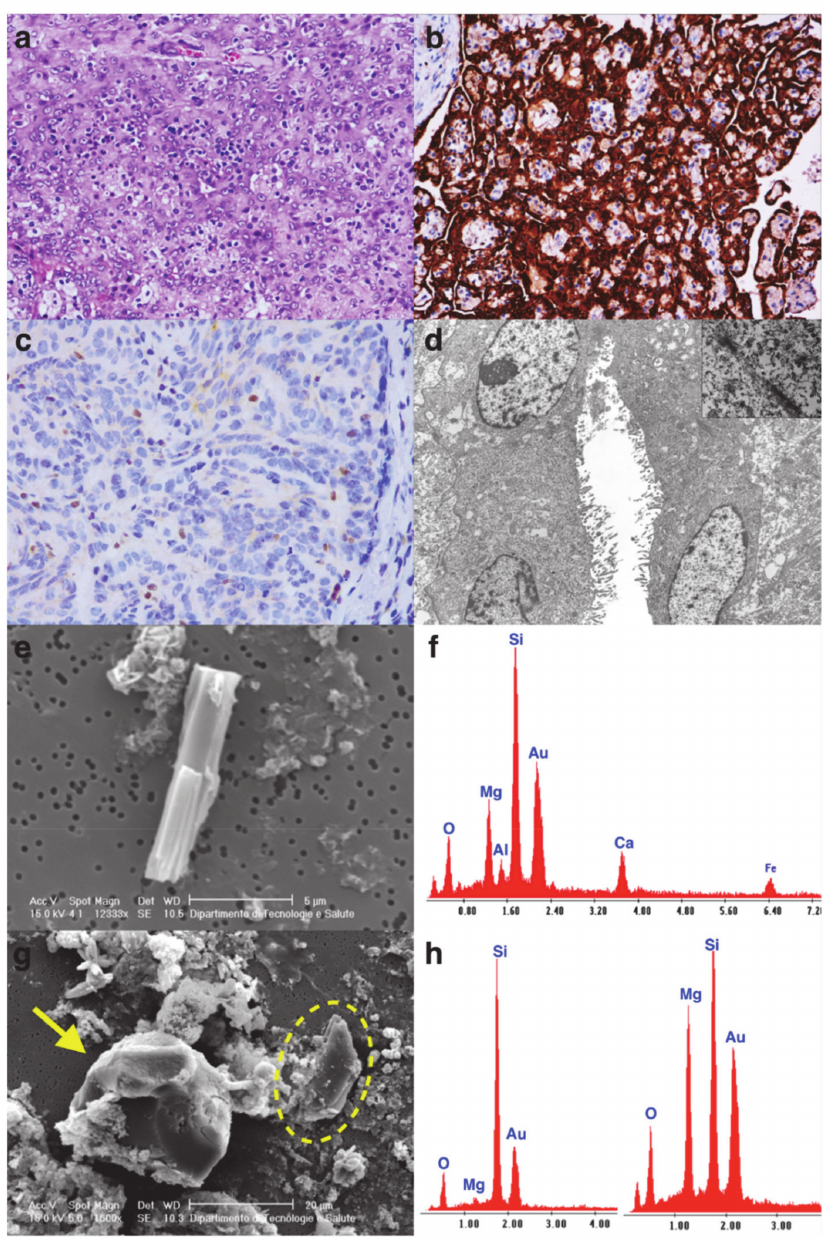
Figure 2. Case 2. Histological section of ovarian mesothelioma with solid and trabecular patterns (( a ) hematoxylin and eosin stain, original magnification × 200) and diffusely immunoreactive calretinin (( b ) immunohistochemistry, original magnification × 200). Lack of nuclear expression of BAP1 (( c ) immunohistochemistry, original magnification × 400). The neoplastic cells showed numerous elongated and branching microvilli on the luminal surface (( d ) original magnification × 4400). At higher magnification, desmosome-like junctions and intracytoplasmic tonofilaments were evident (inset, original magnification × 10,000). The SEM micrograph ( e ) and EDX analysis ( f ) spectrum were morphologically and chemically (chemical formula: Ca2Mg5Si8O22(OH)2) compatible with tremolite fiber. In the same specimen, quartz (( g ) arrow) and talc crystals (( g ) dashed lines) were also evident with the respective EDX analysis spectrum (( h left ) quartz; ( h right ) talc